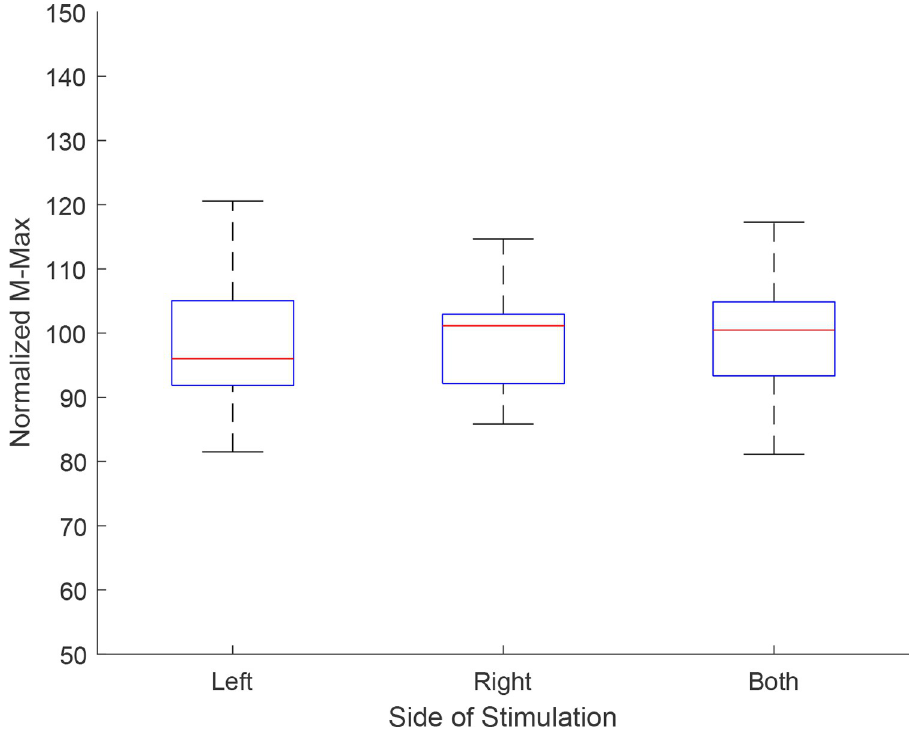
Fig 3. M-max amplitude was monitored for consistency of stimulation. Normalized values of M-max (each value divided by its mean), is shown here for each side of stimulation. The box plot shows the mean and standard deviation for all subjects in each condition. No statistical differences were observed among these three